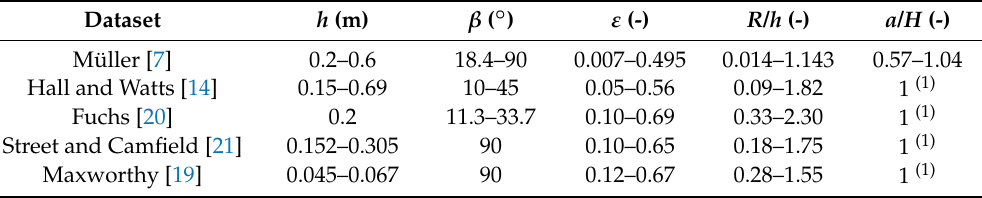
Table 1. Parameter ranges of datasets included in the